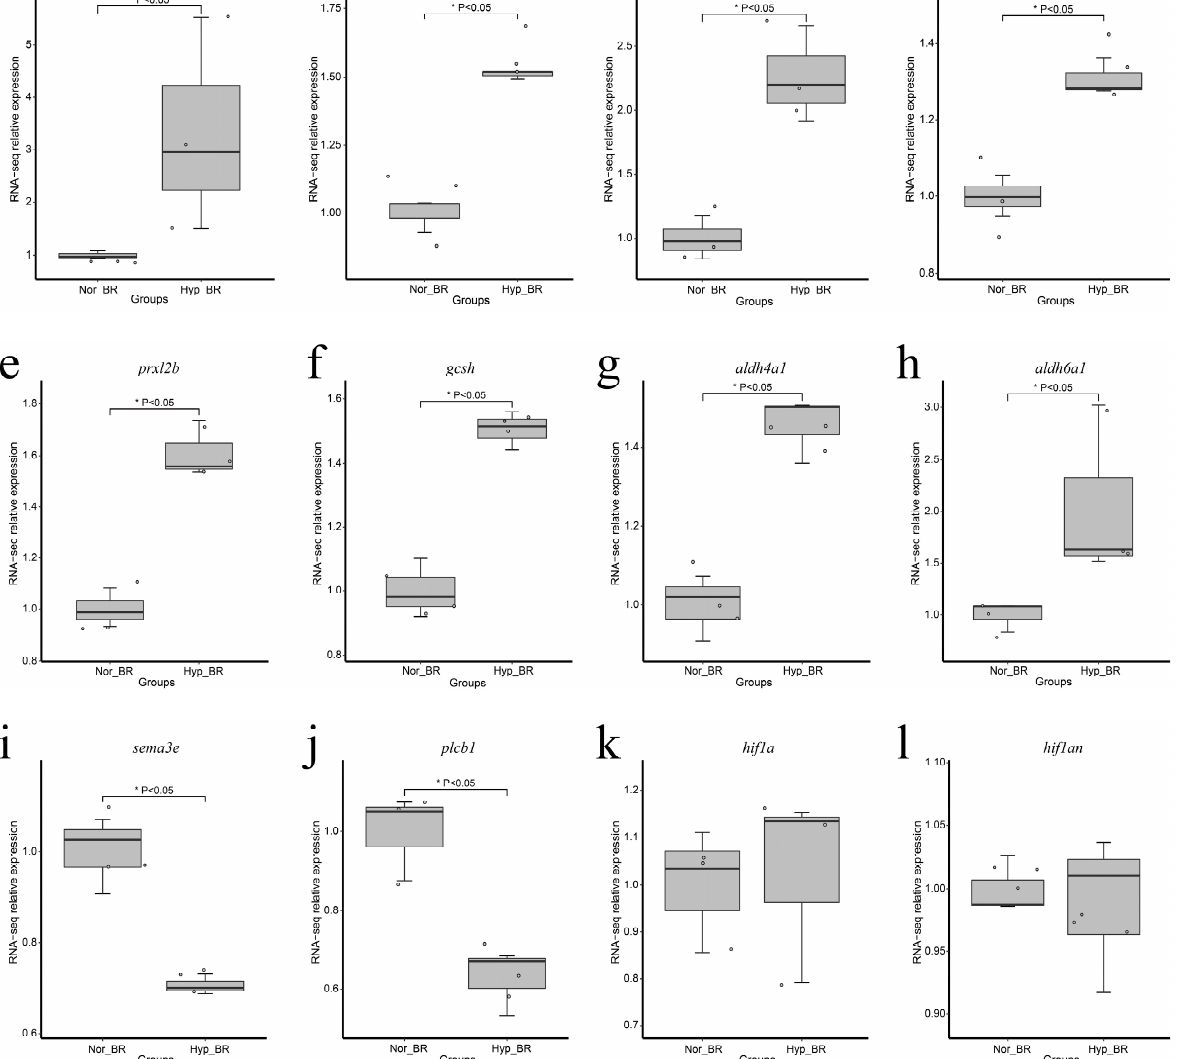
Figure 2. Boxplot shows gene expression at different dissolved oxygen concentrations. The solid line within boxplot represents median, while the boxplot bounds represent the 25 and 75% quantiles, and the dots represent the genes. * Represent P < 0.05 and P < 0.05 was considered statistically significant. The relative expression represents the fold change in expression of the target gene in the experimental group relative to the control group. ( a ) Boxplot for gene aldoa ; ( b ) Boxplot for gene pfkfb4 ; ( c ) Boxplot for gene ugt1a1 ; ( d ) Boxplot for gene pnpla2 ; ( e ) Boxplot for gene prxl2b ; ( f ) Boxplot for gene gcsh ; ( g ) Boxplot for gene aldh4a1 ; ( h ) Boxplot for gene aldh6a1 ; ( i ) Boxplot for gene sema3e ; ( j ) Boxplot for gene plcb1 ; ( k ) Boxplot for gene hif1a ; ( l ) Boxplot for gene hif1an .